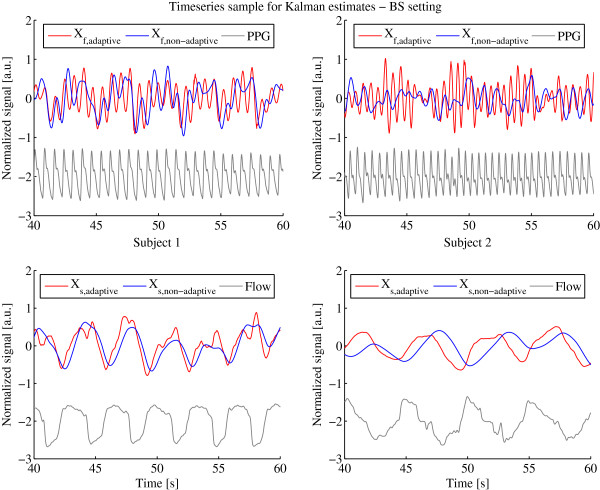
Internal statesXf andXs determined by adaptive and non-adaptive Kalman filter with PPG and Flow Reference using the BS setting. Internal states Xf and Xs determined by adaptive (red) and non-adaptive (blue) Kalman filter with PPG and Flow Reference (gray) using the BS setting for subject 1 (left column) and 2 (right column).